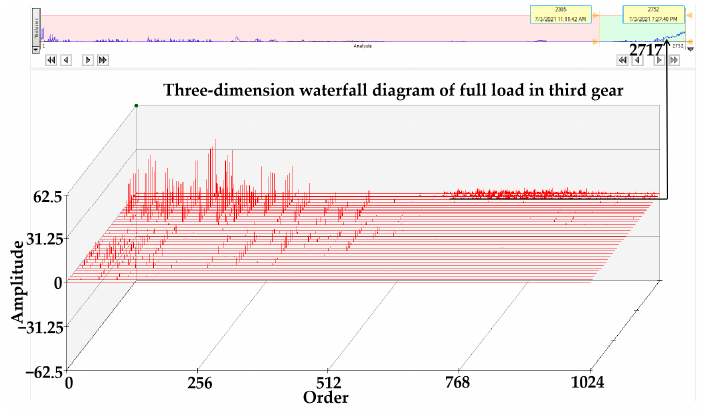
Figure 12. Three-dimension waterfall diagram of full load in third gear.